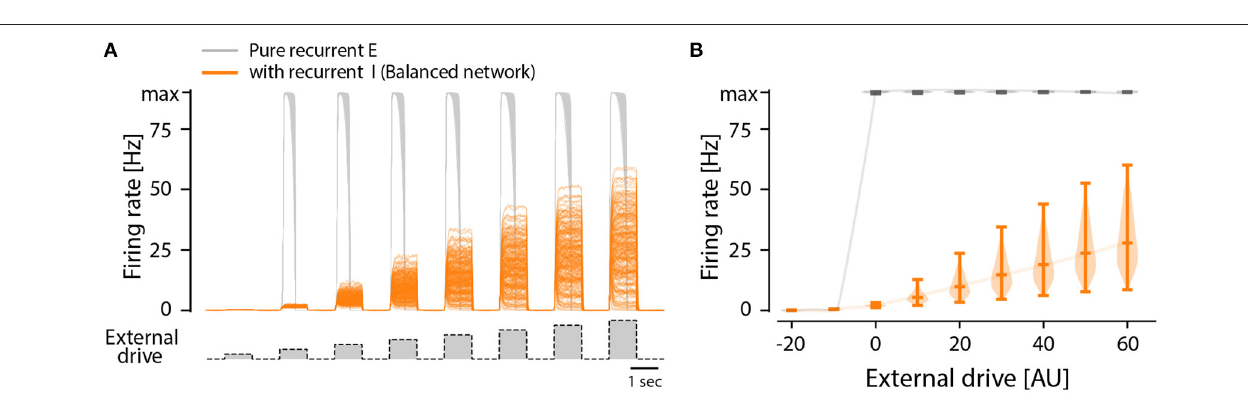
FIGURE 7 | All-or-none vs. graded population response to external drive in two types of model networks: Purely recurrent excitatory network and one including recurrent inhibition, i.e., a balanced network. (A) Firing rates of individual neurons in a recurrent excitatory network (gray) and a recurrent network with both excitation and inhibition (orange), i.e., a balanced network, in response to external drive (bottom trace). All neurons in the excitatory network has the same firing rate, i.e., the maximum or minimum, in response to input, whereas the balanced net has a graded mean response with a wide distribution. (B) The distribution of firing rates across the population in the balanced net (orange) is wide and has a graded response to input, whereas the excitatory network has an all-or-none response that is